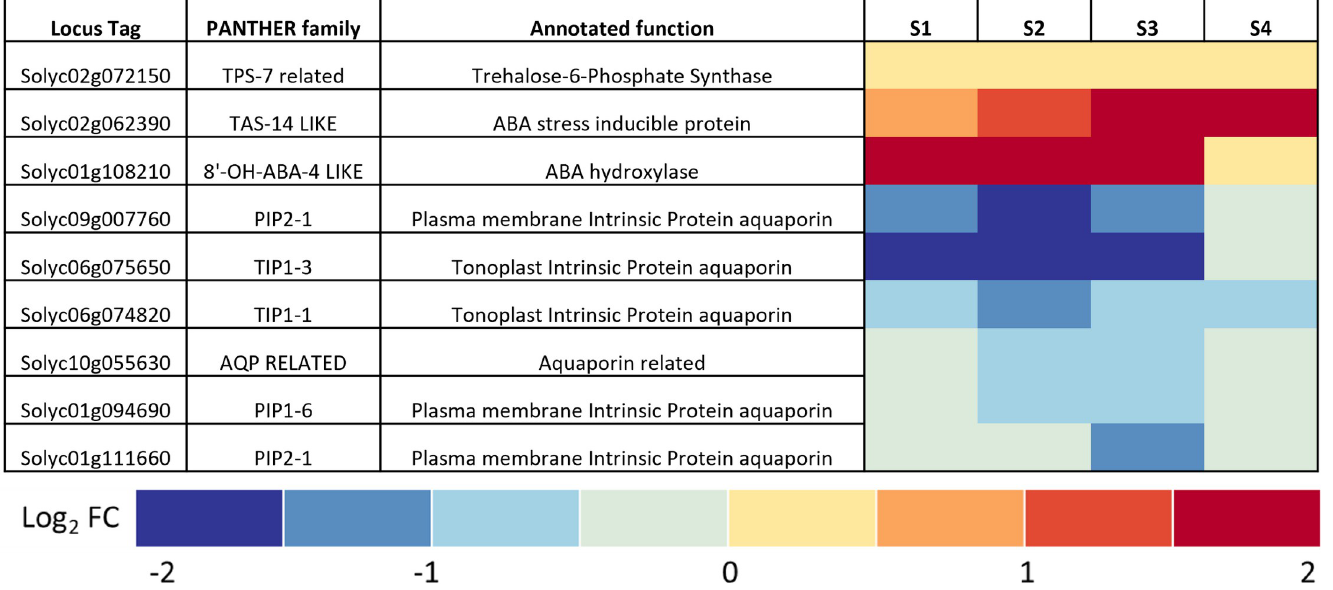
Fig 1. R . solanacearum infection consistently changes expression of nine tomato genes involved in trehalose metabolism and water stress physiology. Meta- analysis of transcriptomic data from four different experiments measuring gene expression of tomato plants responding to infection by R . solanacearum identified nine genes of interest that were commonly differentially expressed across all data sets. The heatmaps show relative expression (as log 2 fold change) compared to mock- inoculated control plants of all tomato genes that were both: 1) Annotated with the terms trehalose , drought , or abscisic acid / ABA ; and 2) Identified by the meta- transcriptomic analysis as significantly differentially expressed across four different tomato RNAseq studies. The four studies were: S1 , roots of wilt-susceptible West Virginia 700 tomato plants (WV) sampled 24 h after infection with R . solanacearum strain K60; S2 , roots of WV sampled 48 h after infection with R . solanacearum strain K60; S3 , seedling roots of wilt-susceptible cv. Bonny Best (BB) sampled 24 h after infection with R . solanacearum strain GMI1000; S4 , mid-stems of BB sampled 72 h after inoculation with R . solanacearum strain GMI1000. Tomato locus tags, gene names, and PANTHER families are from NCBI and the Sol Genomics Network, accessed in 03/2020. Transcriptomic data were normalized across experiments to allow comparisons as described in Methods.